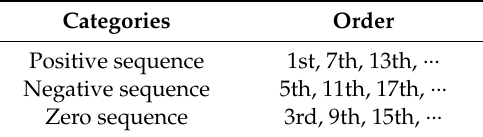
Table 1. Sequence of harmonic